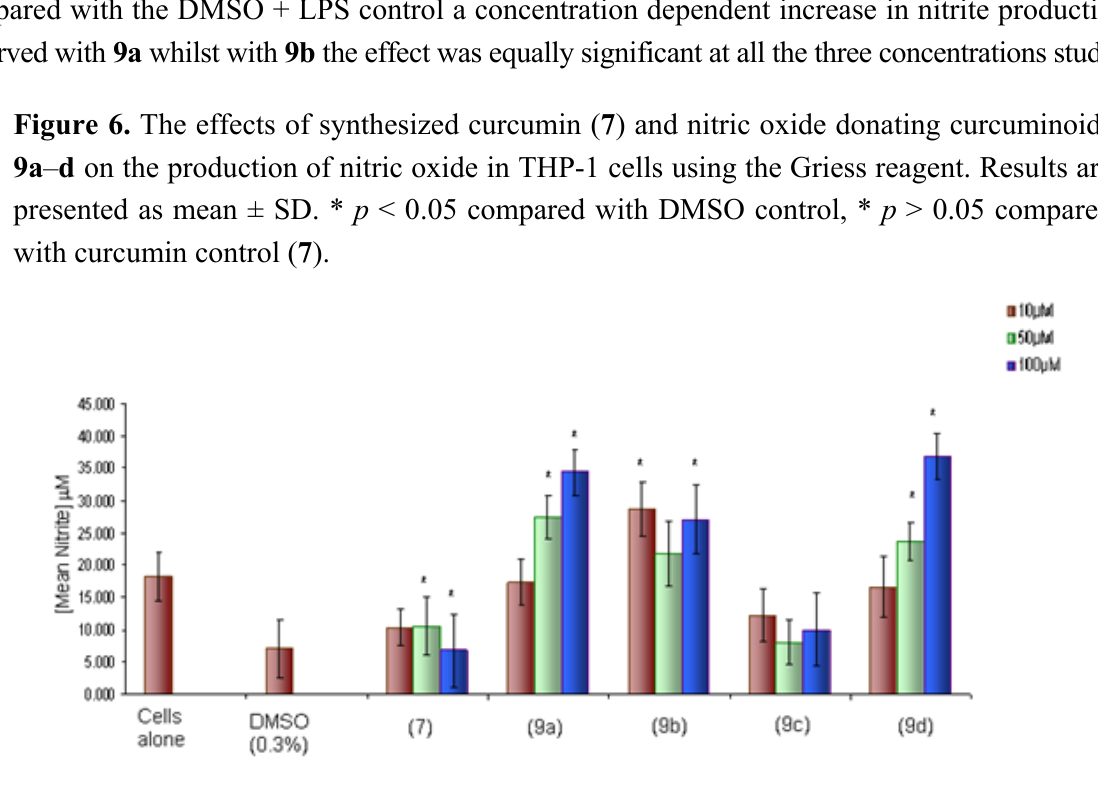
Figure 7. The effects of synthesized curcumin ( 7 ) and nitric oxide donating curcuminoids 9a – d on the production of nitric oxide in LPS-induced THP-1 cells using the Griess reagent. Results are presented as mean ± SD. * p < 0.05 compared with DMSO + LPS control, * p > 0.05 compared with curcumin control ( 7